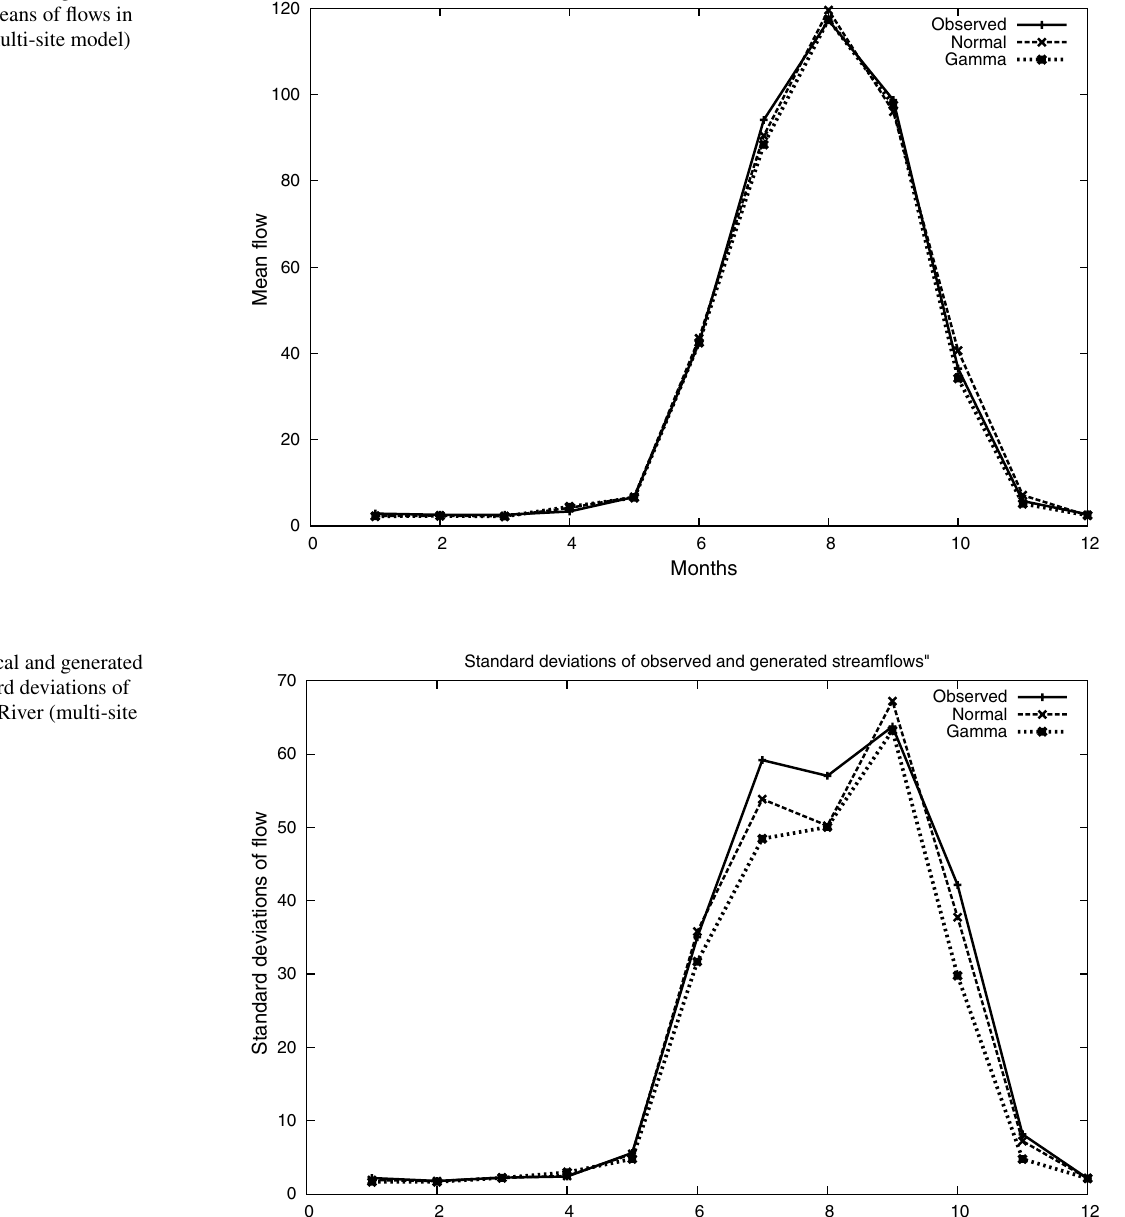
Fig. 11 Historical and gener- ated monthly means of flows in Konar River (multi-site model)